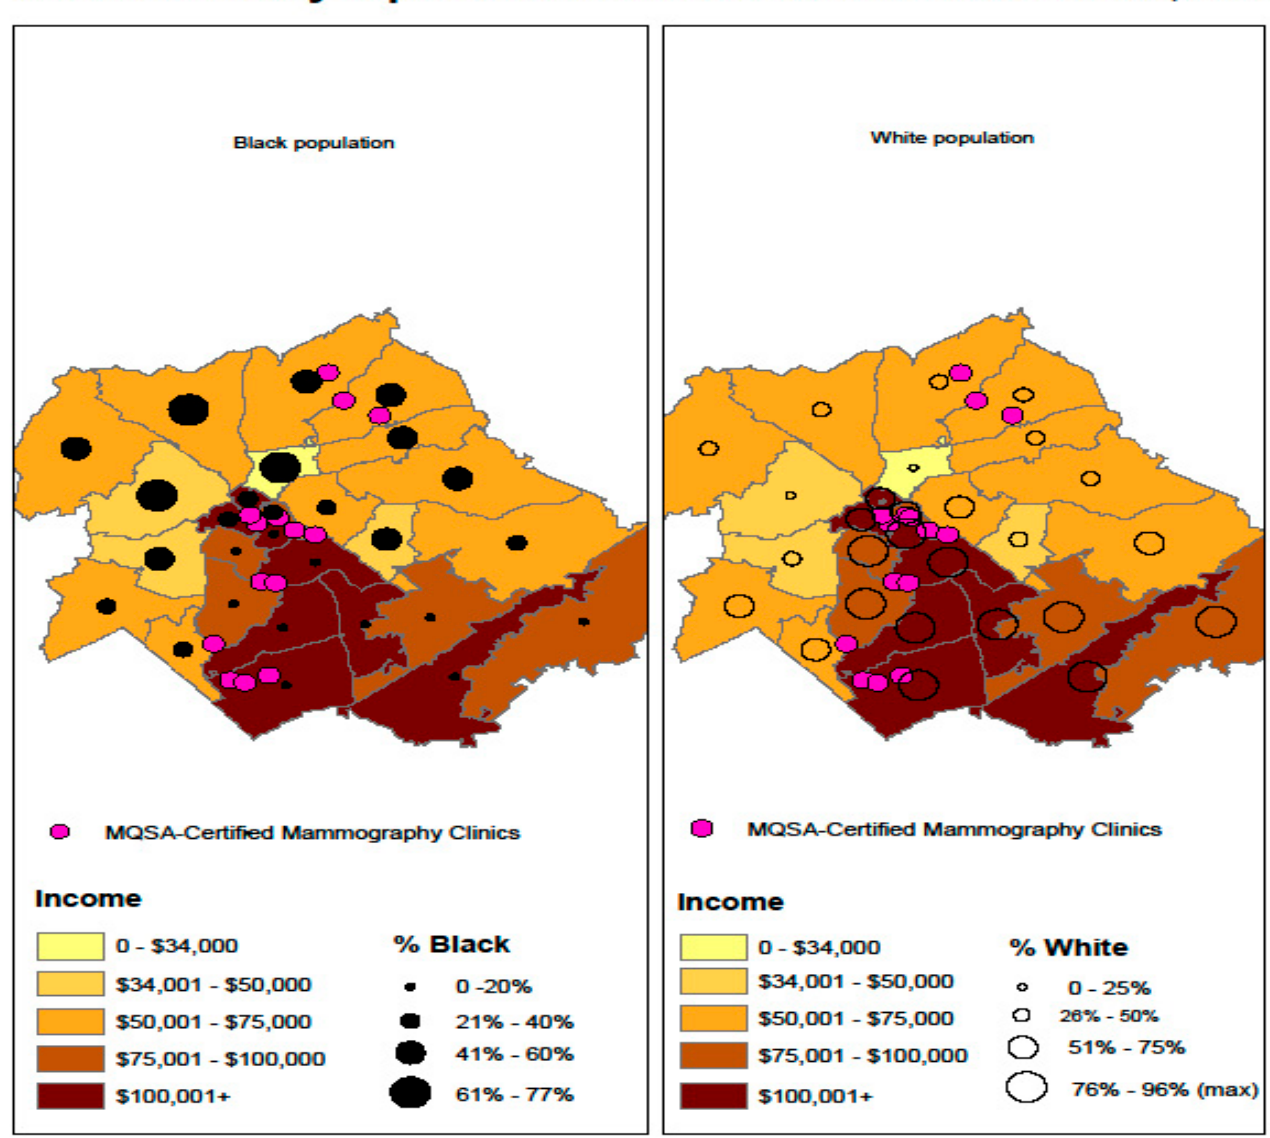
Figure A9. Percent Black vs. Percent White Population, MQSA-Certified Mammography Clinics, and Income by ZIP Code Tabulation Area in Charlotte, NC.